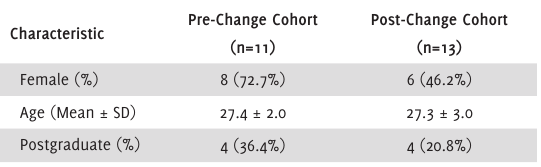
Table 1. Participant Demographics